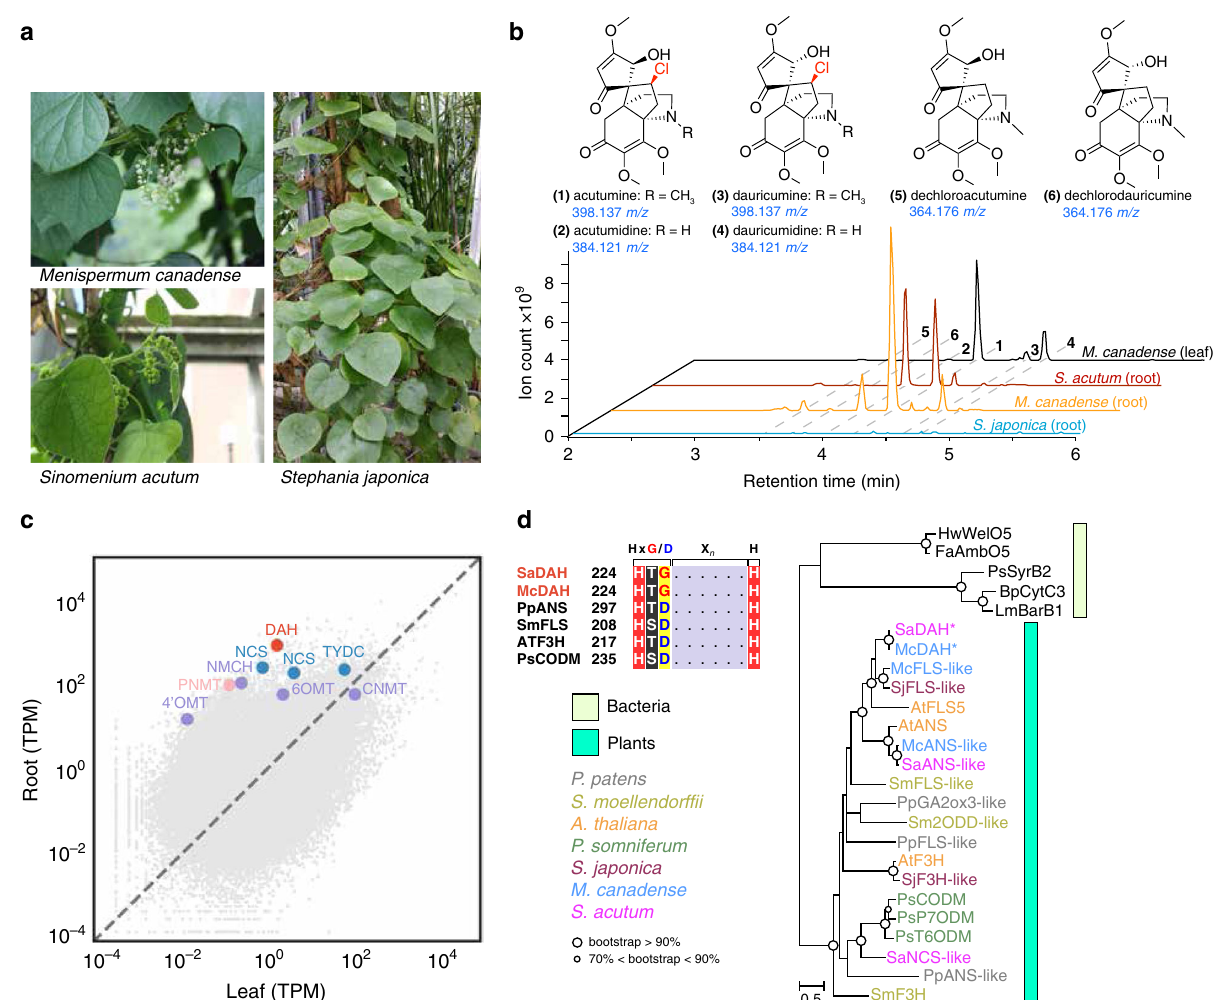
Fig. 1 Identi fi cation of candidate genes encoding DAH in Menispermaceae plants. a Images of M. canadense , S. acutum , and S. japonica plants. b Extracted ion chromatograms (XICs) exhibiting the presence and absence of ( − )-acutumine and its related compounds in three Menispermaceae plants. c Transcript differential expression analysis in M. canadense root vs. leaf tissues. Transcript abundance is quanti fi ed by transcripts per million (TPM) values. Candidate ( − )-acutumine biosynthetic enzymes are colored based on their postulated roles in the proposed pathway depicted in Supplementary Fig. 1. d Sequence and phylogenetic analysis of DAH. The insert at the upper left corner shows multiple sequence alignment of two DAHs and other ODDs highlighting the Hx (D/G)X n H motif. The full sequence alignment is shown in Supplementary Fig. 3. The phylogenetic tree of DAHs together with select 2ODD-family proteins is inferred using maximum-likelihood method. Bootstrap statistics (200 replicates) are indicated at the tree nodes. The scale measures evolutionary distance in substitutions per amino acid. Asterisks denote the two orthologous DAHs identi fi ed in this study. The multiple sequence alignment used for building the phylogenetic tree is in Supplementary File 1. NCS norcoclaurine synthase, TYDC tyrosine decarboxylase, PNMT pavine N-methyltransferase, 6OMT ( RS )-norcoclaurine 6- O -methyltransferase, CNMT ( S )-coclaurine N -methyltransferase, NMCH ( S )- N -methylcoclaurine-3-hydroxylase, 4 ′ OMT ( S